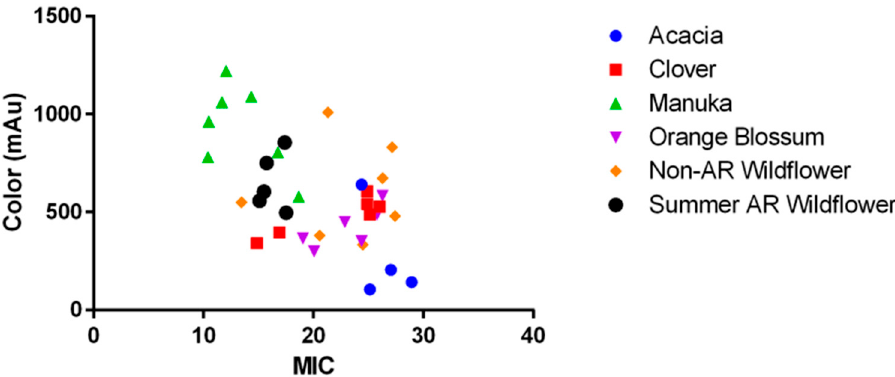
Figure 5. Relationship between a honey’s color (as measured by spectrophotometric analysis) and average MIC against all species tested. There is a moderate correlation (Pearson’s R = − 0.581, p < 0.0001, n = 38) where darker colored honeys inhibit bacteria at a lower MIC.